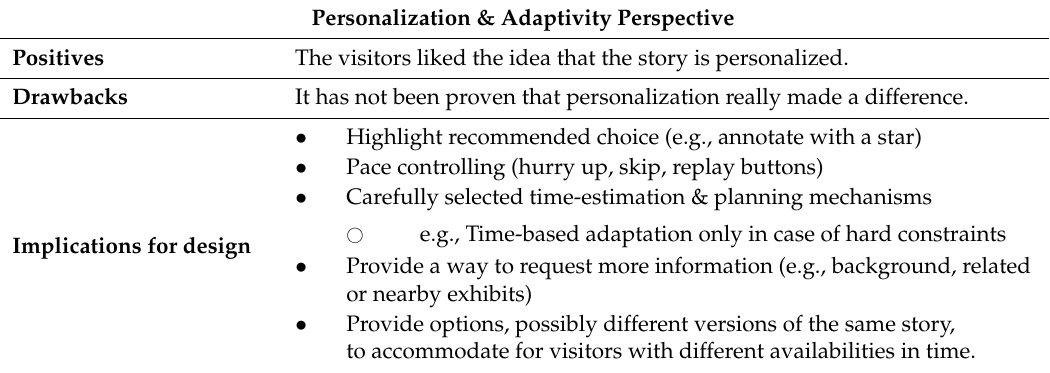
Table 9. Insights from findings on the personalization perspective, and implications for